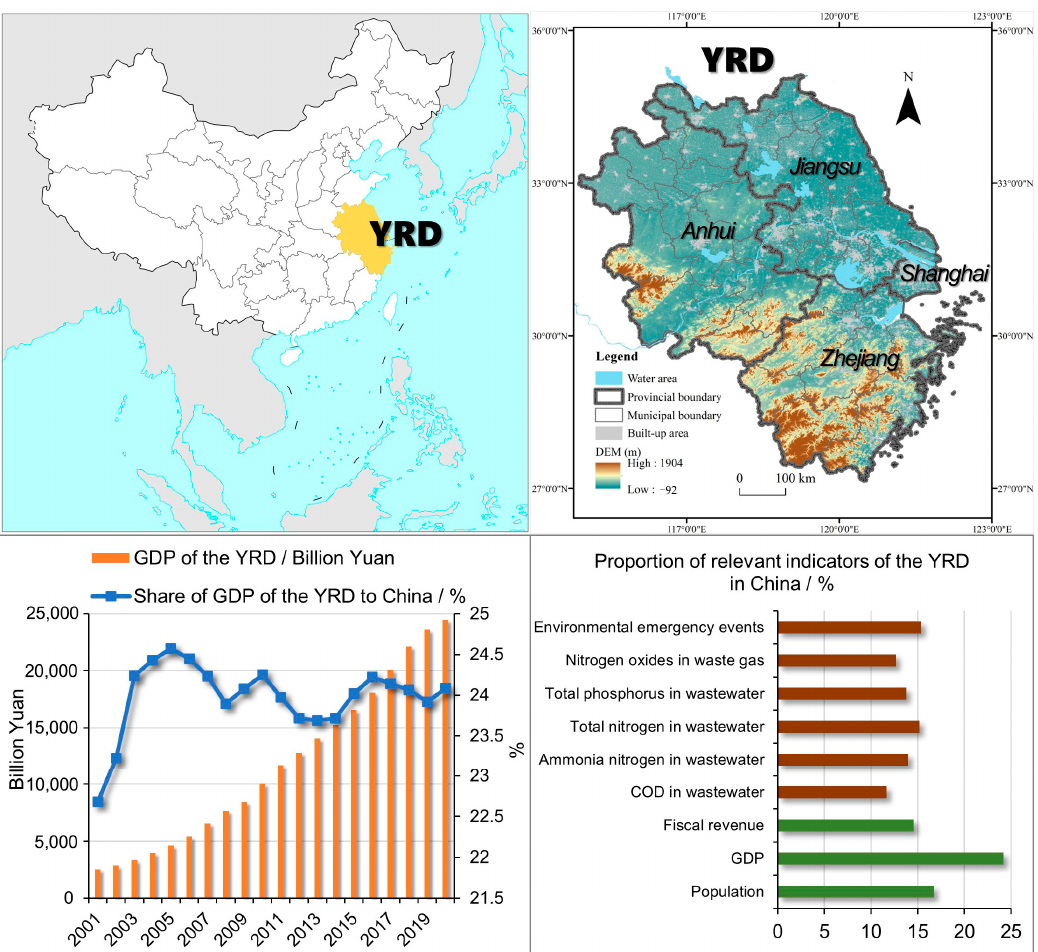
Figure 1. Geographical location and socioeconomic overview of the YRD.